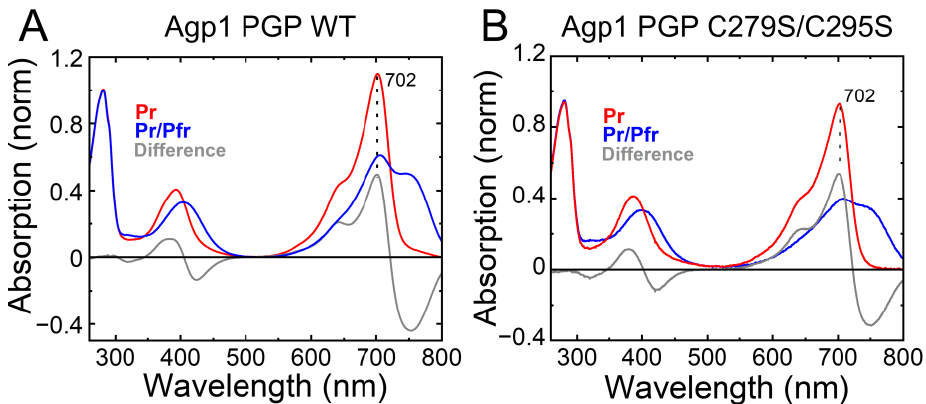
Figure 4. Characterization of the accessible cysteine-less base variant Agp1 PGP C279S/C295S. The UV–Vis absorption spectra in the Pr state (in red), after illumination in the Pr/Pfr state (in blue), and the difference spectra (in grey) are shown. The maximum absorbance wavelength of the Pr state peak is given. ( A ) Agp1 PGP WT. ( B ) Agp1 PGP C279S/C295S. Conditions: 300 mM NaCl, 50 mM Tris, pH 7.8 at 20 ◦